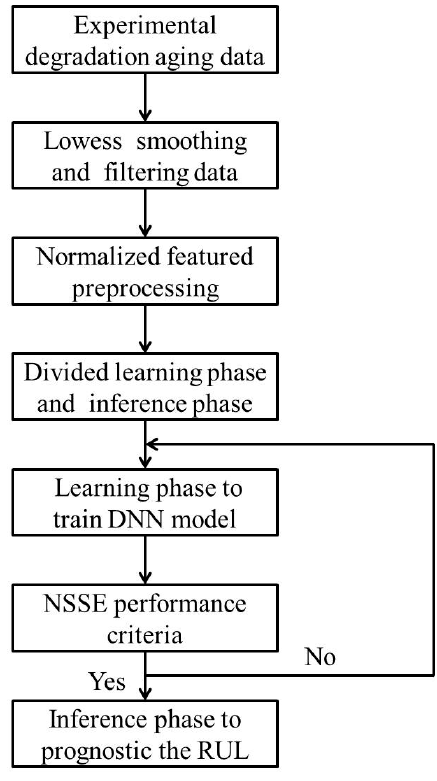
Figure 3. Flow chat of the DNN model for SOFC system prognostic.